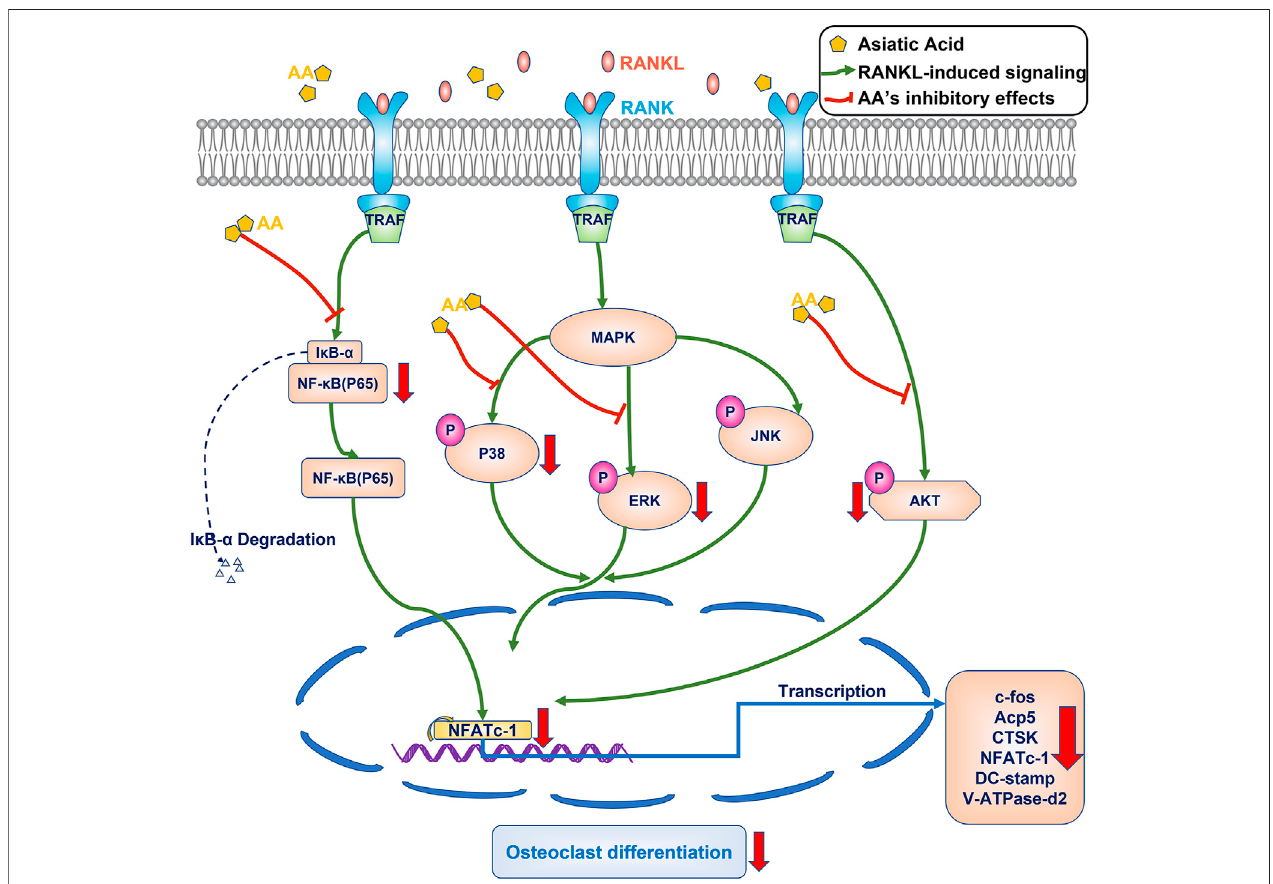
FIGURE 6 | Proposed scheme for mechanism by which asiatic acid inhibits osteoclastogenesis. After binding to RANKL, the RANK can recruit and activate the TRAF6, the NF- κ B/MAPK/Akt signaling pathway are activated, resulting in the self-ampli fi cation of NFATc1. NFATc1 regulates the expression of osteoclast speci fi c genes, including c-fos, CTSK, Acp5, DC-stamp, and V-ATpase-D2. Our results demonstrate that AA can inhibit osteoclastogenesis by inhibiting the NF- κ B/MAPK/Akt signaling pathway.